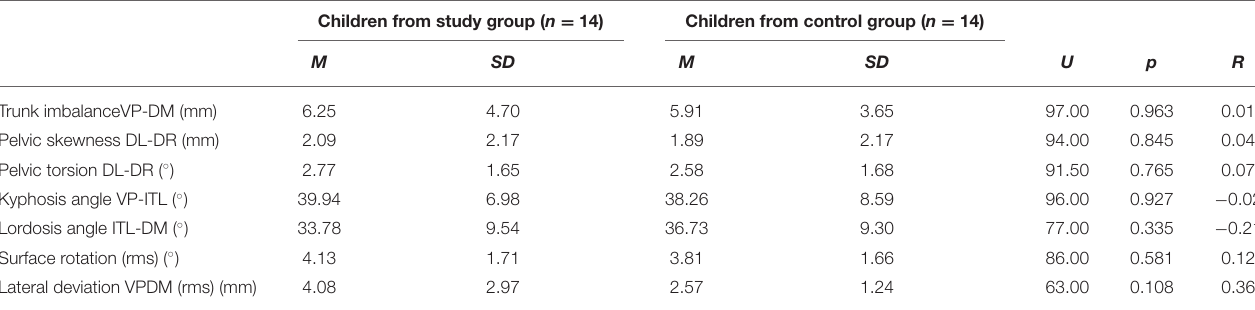
TABLE 5 | Mean scores, standard deviations and the significance of differences in indicators of body posture in children aged 9–10 years, depending on the occurrence of chest pain. Children from study group ( n = 20) Children from control group ( n = 33) SD